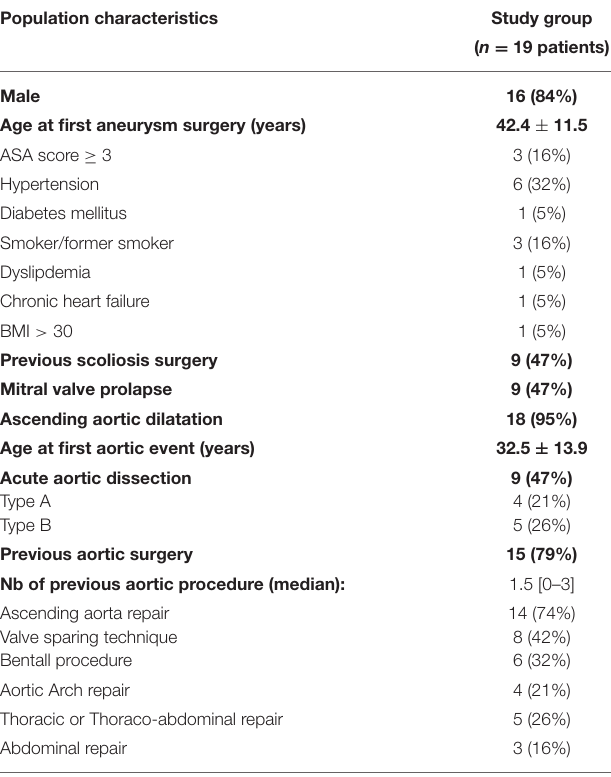
TABLE 1 | Baseline characteristics of the study group ( n = 19 patients). Population